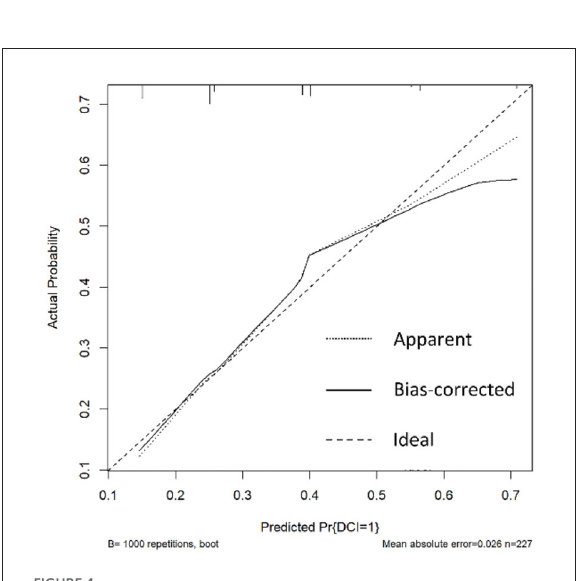
FIGURE4 Calibration curve (Based on DCI group, non-DCI group).